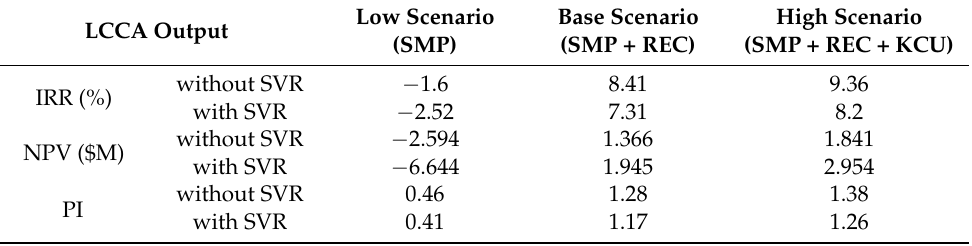
Table 6. A summary of life cycle cost analysis (LCCA) for all cases and